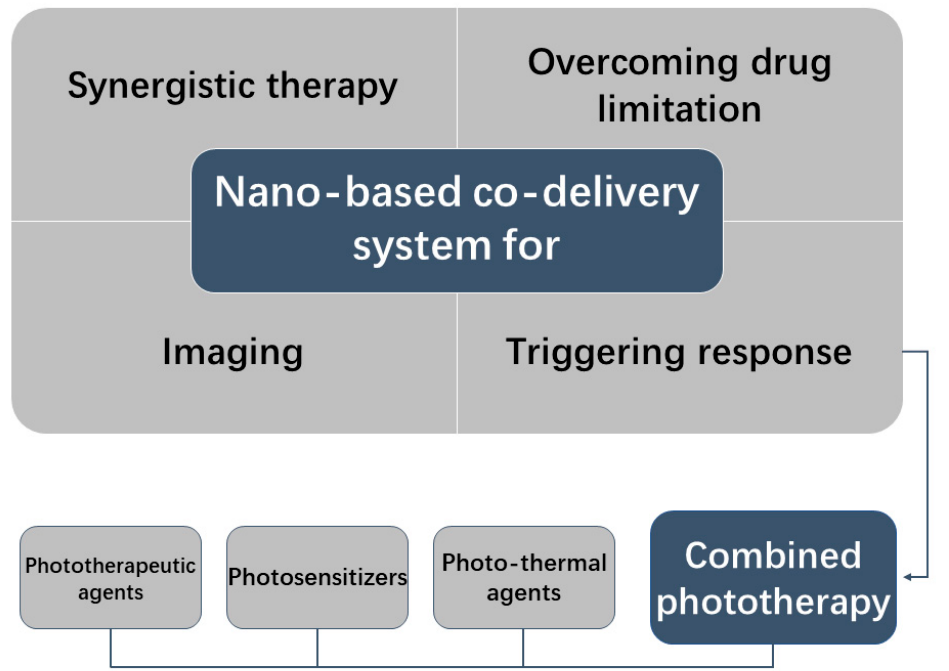
Figure 1. A brief graphical scheme of this review.